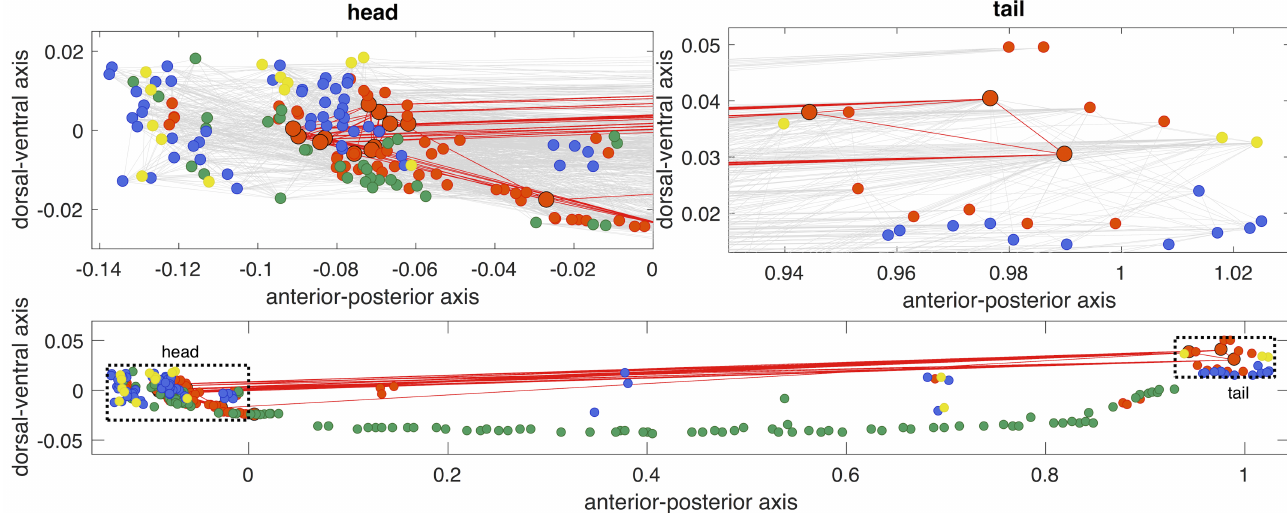
Fig 2. Hub neurons are contained within the head and tail of C. elegans . Neurons are positioned along the anterior–posterior (horizontal), and dorsal–ventral (vertical) axes, and are colored by type: (i) interneuron (85 neurons, orange), (ii) sensory (68 neurons, blue), (iii) motor (108 neurons, green), or (iv) multiple assignments (18 neurons, yellow). Hub neurons (i.e., neurons with k > 44, see Fig 5) are shown as larger circles and outlined in black. ‘Rich-club’ connections between hub neurons are shown (red), and all other connections are also shown in the upper plots (gray). Axes of each subplot are to scale with each other, and the upper zoomed-in plots of the head and tail are shown as dotted rectangles in the lower plot.